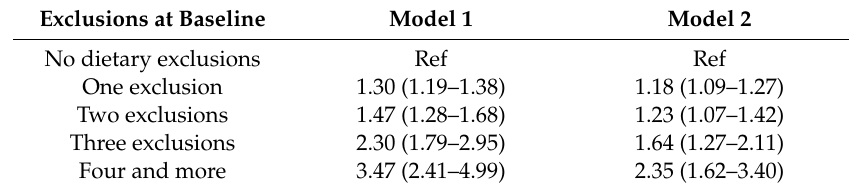
Table 3. Odds ratio (OR) and 95% confidence intervals (CI) from logistic regression for the odds of having depressive symptoms (binary measure) at follow-up associated to dietary exclusions at baseline (N =